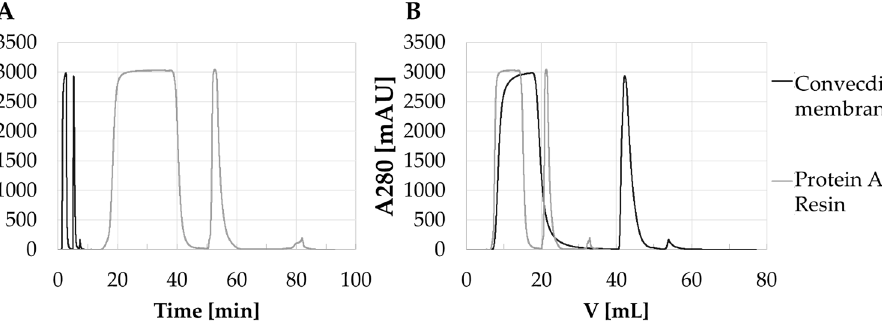
Figure 5. Comparison of ( A ) cycle time and ( B ) volumes of one single cycle of mAb capture with protein A resin versus convecdiff membrane adsorber. protein A resin versus convecdiff membrane